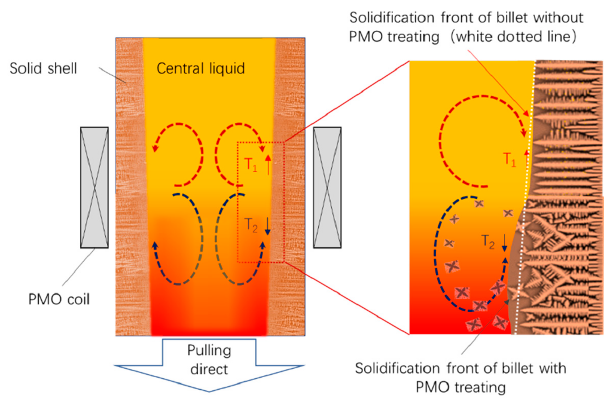
Figure 8. Schematic diagram of the effects of PMO on the temperature field of liquid phase and solidified shell growth of the billet (longitudinal cross section). solidified shell growth of the billet (longitudinal cross